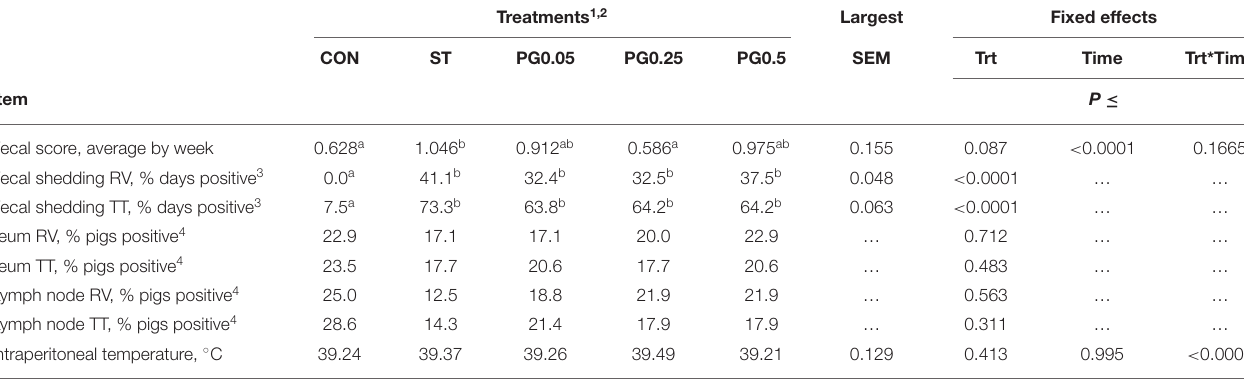
TABLE 4 | Health effects of a ceramic particle fed to pigs after a S. enterica serotype typhimurium infection. Treatments 1,2 Largest Fixed